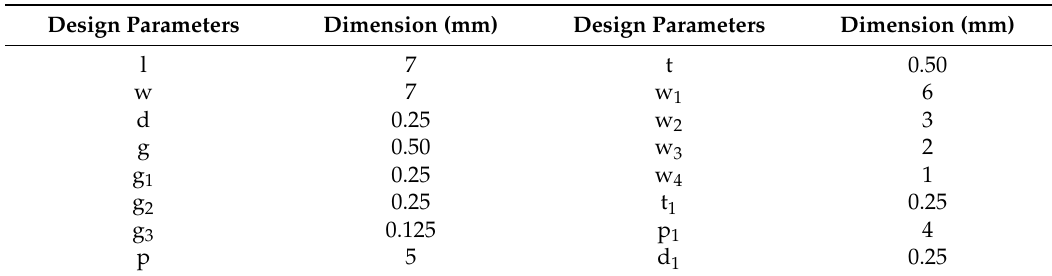
Table 1. Design specifications of the metamaterial unit cell.